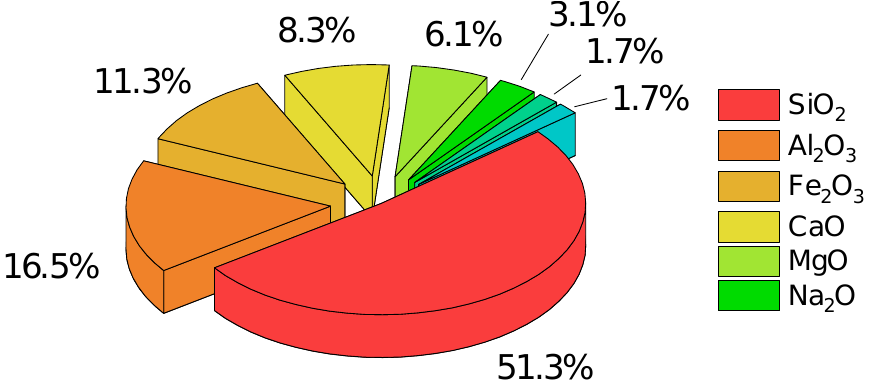
Figure 1. Chemical composition of basalt fibers